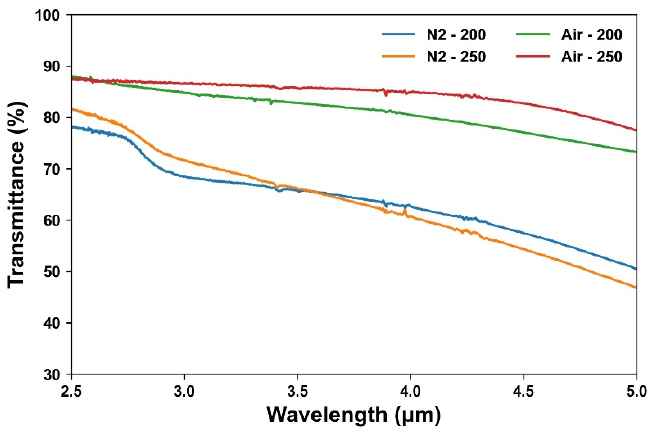
Figure 13. Mid-infrared transmittance of In 2 O 3 :H films in different annealing atmospheres.